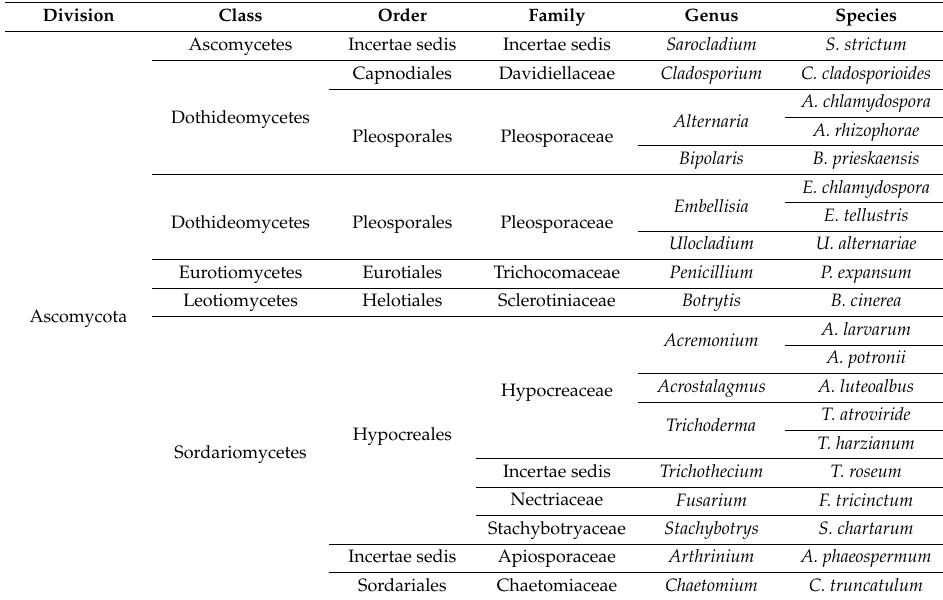
Table 2. List of microfungi harvested from soils of the National Park of Urmia Lake (localities: Kaboudan Island, Espir Island, Golmankhaneh Port, Mahabad Road) [7]. Class Order Family Genus Species